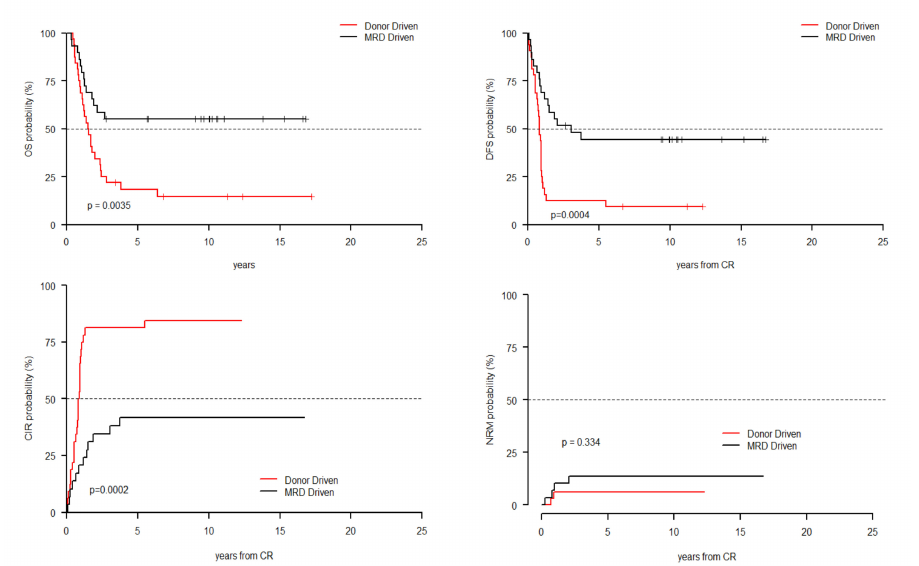
Figure 2. Clinical outcome of 68 MRD positive patients according to cohort allocation. MRD-driven cohort did better both in terms of OS (55.2% vs. 14.6%, p = 0.0035) and DFS (44.3% vs. 9.4%, p = 0.0004), with a lower CIR ( p = 0.002). NRM was not statistically different between the two cohorts.